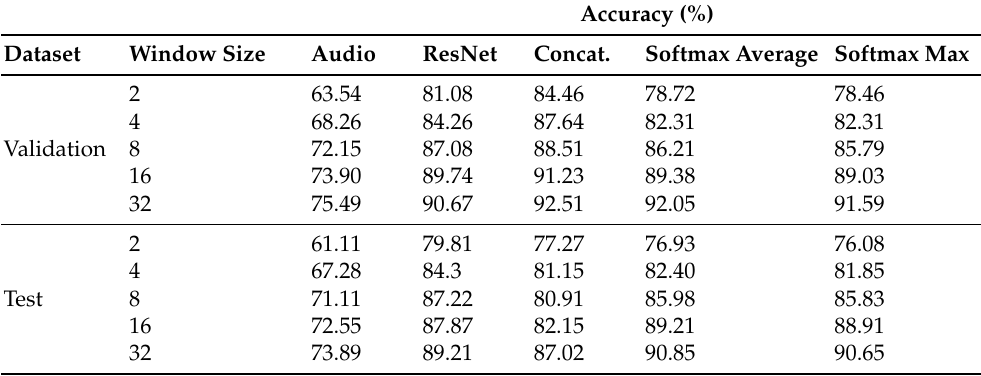
Table 5. Comparison of the accuracy (%) of classification on the validation and test sets, for different models and fusion alternatives. The audio model is described in Section 3.4, and the video-based 2D-CNN model with pre-extracted ResNet features is described in Section 3.3. The fusion of the audio and video features is performed using early fusion (concatenation) or late fusion (either softmax average or softmax max), as described in Section